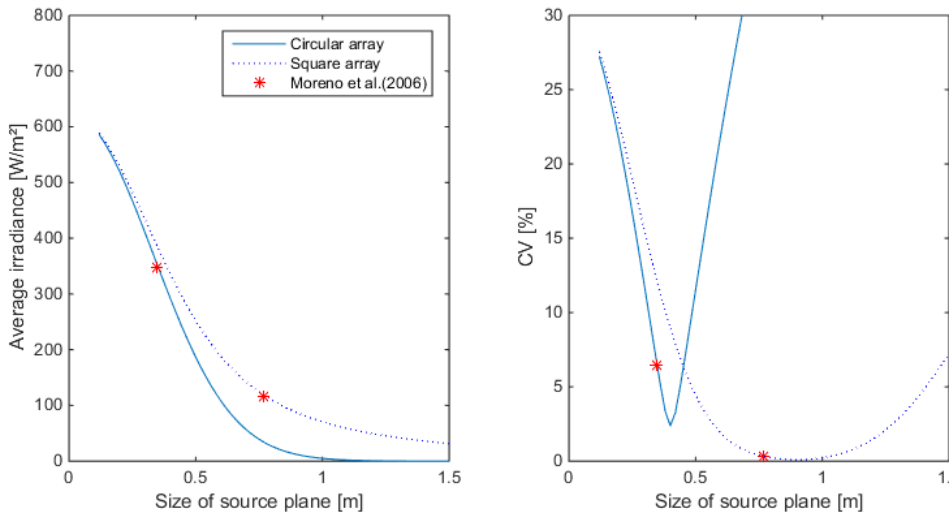
Figure 8. Average irradiance and CV as a function of the source plane size for square and circular arrays of 36 LEDs. Simulations are done with the medium beam lens. ( Left ): Average irradiance; ( Right ): CV.